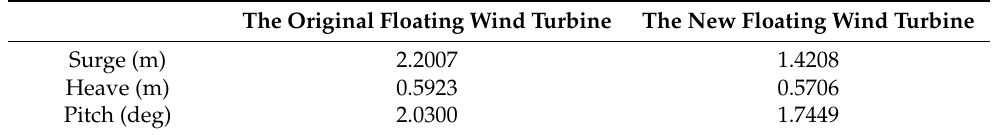
Table 11. RMS of responses to two types of wind turbine under storm self-survival condition.